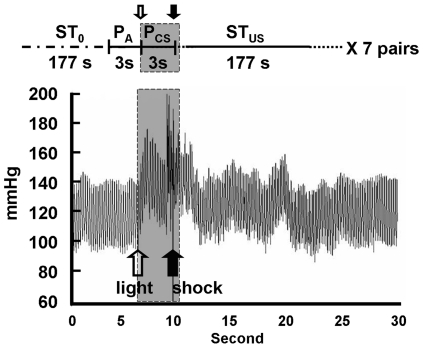
A schematic diagram showing BP alterations induced by light (CS) and footshock (US) during the training session of fear-potentiated startle.The light-on period is marked as the shaded region. PA: averaged BP in 3 s before light on; PCS: averaged BP in 3 s after light on; ST0: averaged resting sympathetic tone in 177 s before the initial PA; STUS: averaged post-US sympathetic tone in 177 s starting at 3 s after a footshock.